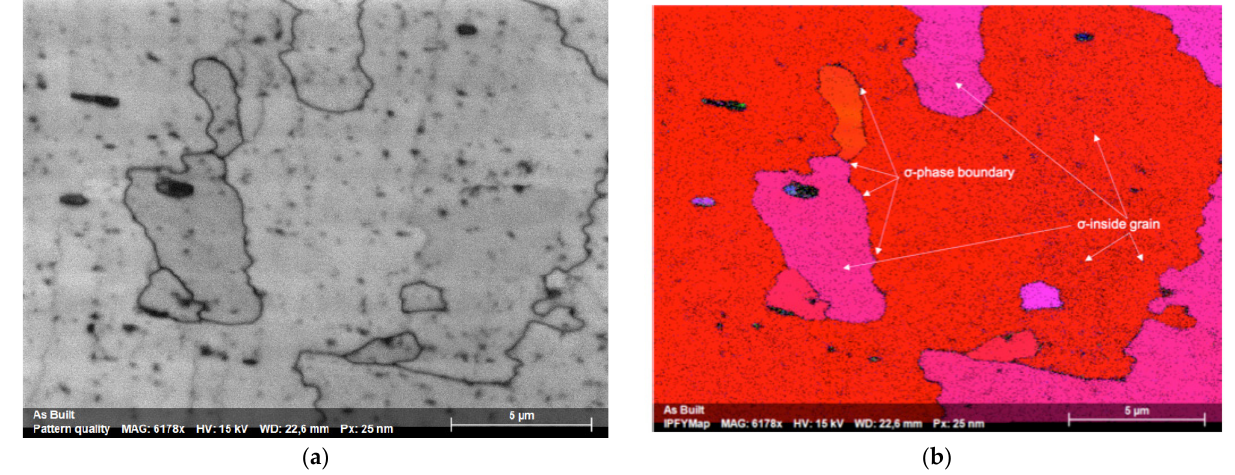
Figure 4. Optical micrographs of the as-built SLM HEA observed in transversal section. ( a ) Columnar grains aligned towards the build direction. ( b ) Dendritic structures inside the grains.